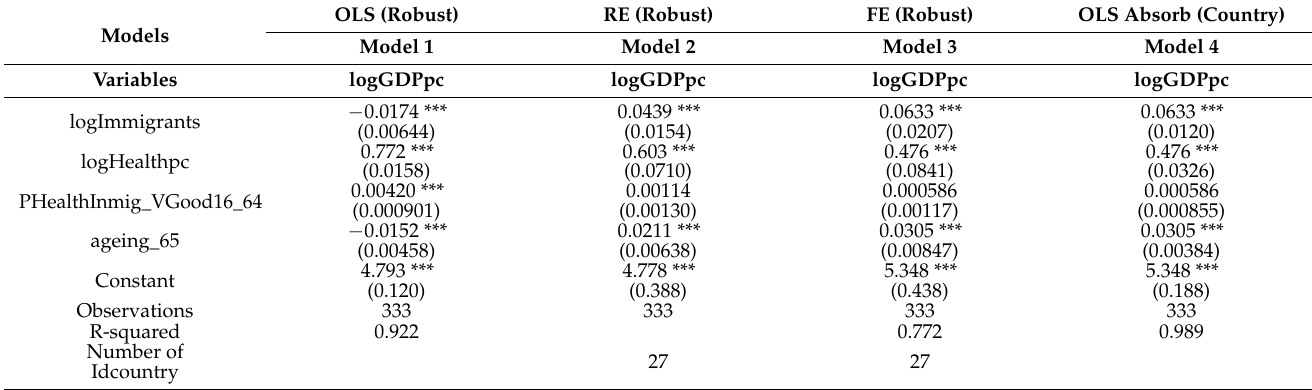
Table 2. OLS, RE, FE, and OLS Absorb (country) all robust models.